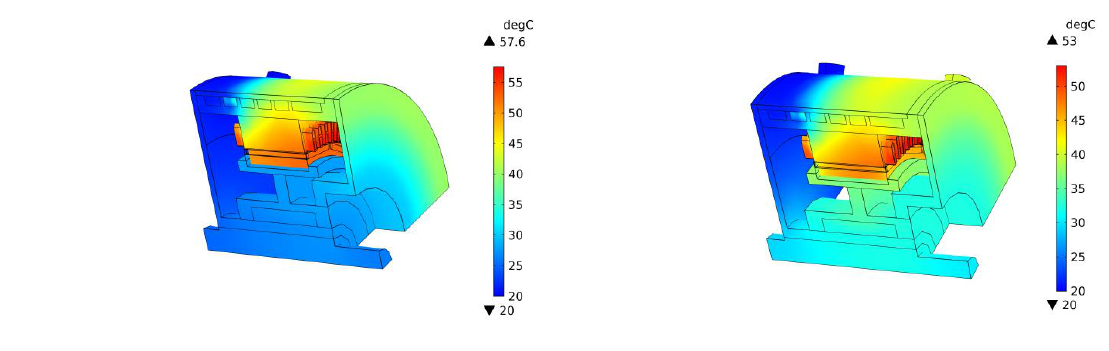
Figure 13. In-wheel motor temperature diagram.